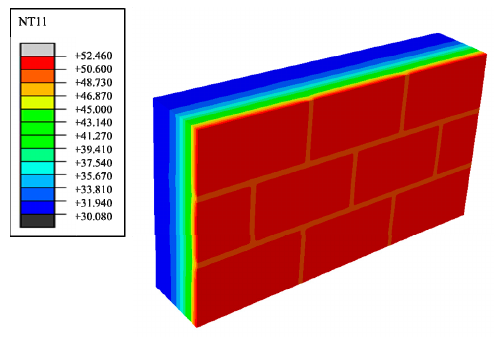
Figure 11. Transient heat transfer temperature peak nephogram. Materials 2019 , 12 , x FOR PEER REVIEW